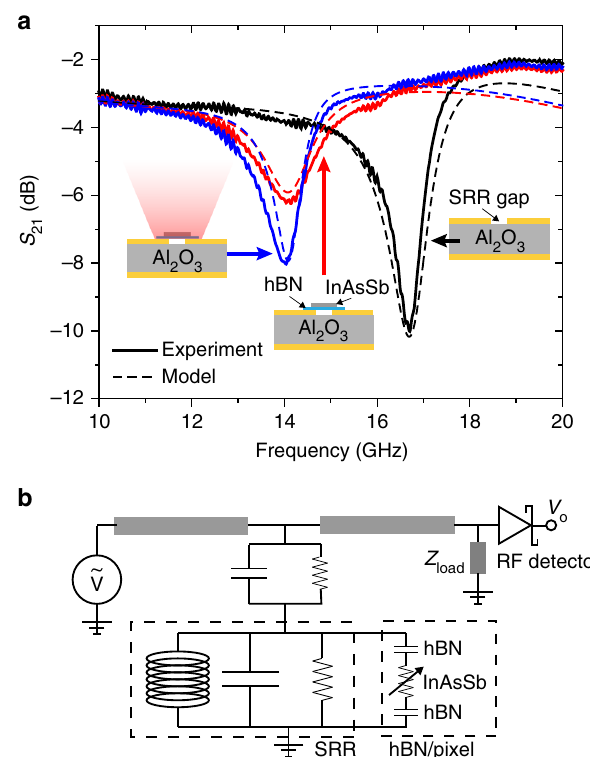
Fig. 3 Modeling the coupled pixel-resonator circuit. a Experimental (solid) and modeled (dashed) S 21 spectra for microstrip resonator without pixel (black), after loading with hexagonal boron nitride (hBN) and InAsSb pixel (red), and under illumination of the InAsSb pixel post-loading (blue). b Equivalent circuit model of a split-ring resonator (SRR) capacitively coupled to a microstrip transmission line terminated by a load. The hBN/ pixel structure is depicted as a shunt with parallel capacitance (hBN) and variable conductance (InAsSb